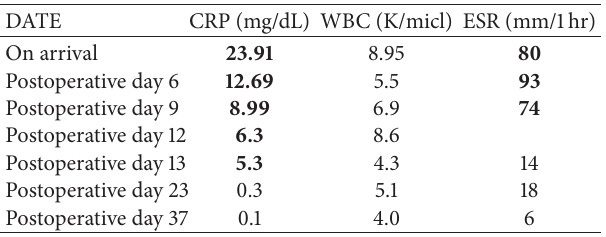
Table 1: Sequential inflammatory markers of the patient (high levels are indicated in